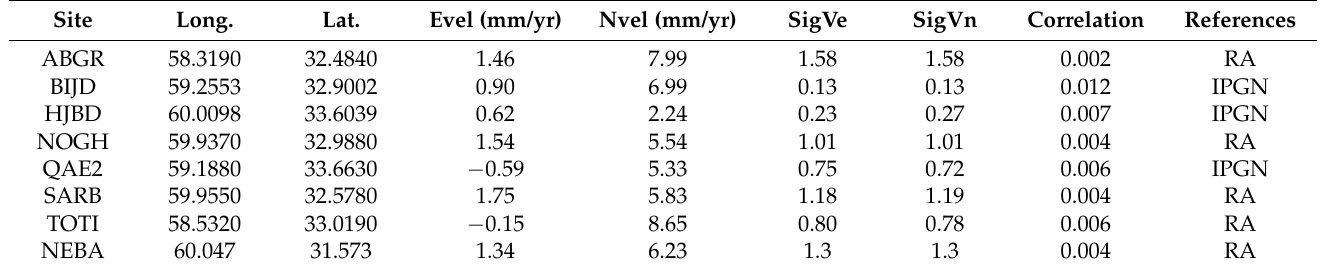
Table 1. The GPS (Global Positioning System) stations in the area, their locations, velocities (Evel, Nvel in mm/yr), and their root mean square (SigVe and SigVn) uncertainties with respect to the Eurasia-fixed frame in east and north direction. RA = stands for reference [39]; IPGN = Iranian Permanent GNSS